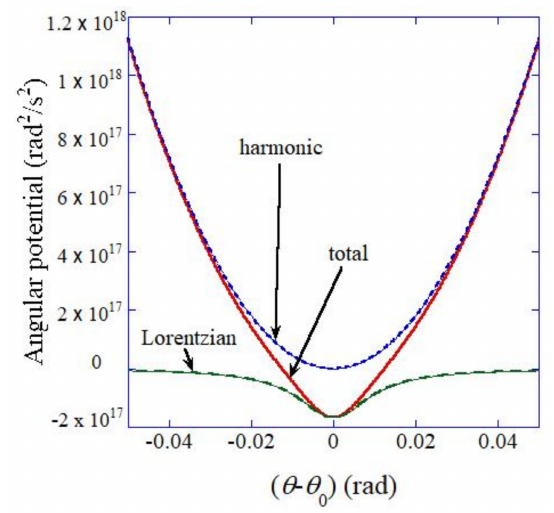
Figure 2. Assumed angular potential (Equation